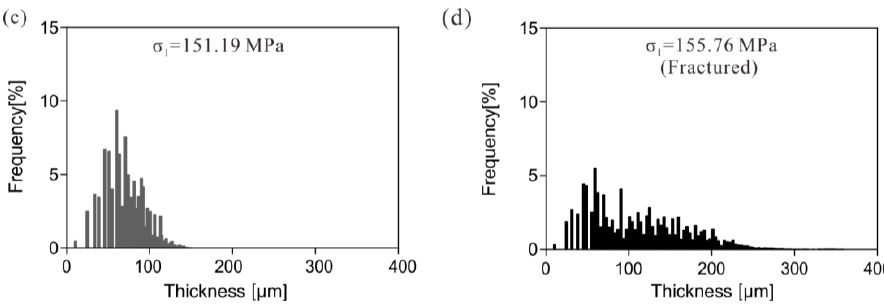
Figure 12. Crack propagation pattern of different load stages in SZB4. ( a ) σ 1 = 151.19 MPa; ( b ) Fractured specimen (after σ 1 = 155.76 MPa); ( c ) crack thickness at σ 1 = 151.19 MPa; ( d ) crack thickness (after σ 1 = 155.76 MPa). Rainbow colors represent the thickness value ranges from low to high, and red means highest. The cross-sectional views show the center slice of the specimen.